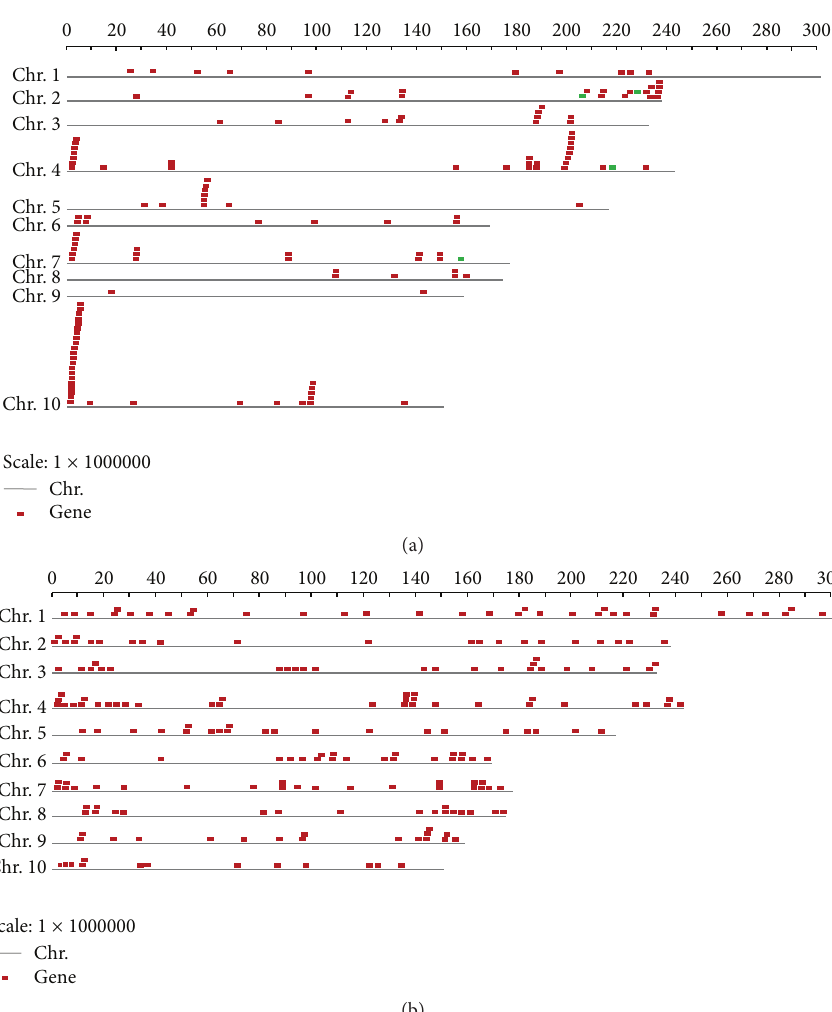
Figure 1: Physical locations of the Zea mays R genes encoding LRR: (a) physical locations of NBS-LRR genes; (b) physical locations of LRR- RLK genes. The boxes above the chromosomes (Chr.; gray bars) indicate the approximate locations of each gene. Red boxes indicate the CC-NBS-LRR genes, while green boxes indicate TIR-NBS-LRR genes. Chromosome lengths are shown in megabase pairs on the scale at top.